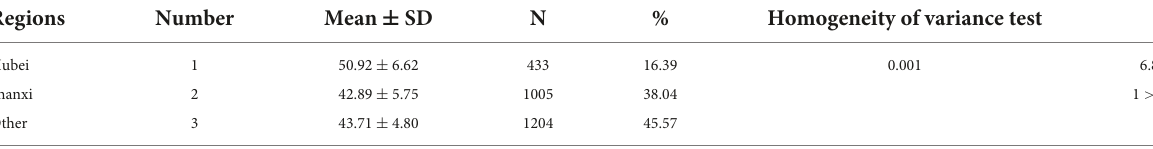
TABLE 7 Comparison of GSI T-score among different regions. Regions